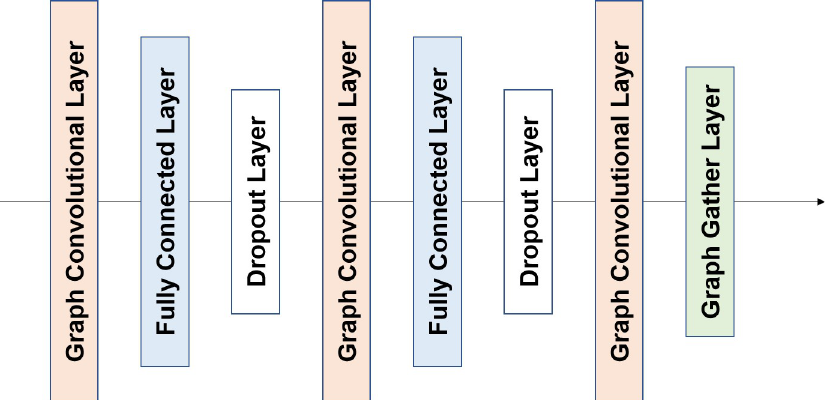
Fig 3. The framework of the graph convolutional block. Each graph convolutional block consists of three graph convolutional layers. The graph convolutional layers are combined with a fully connected layer and a dropout layer, except for the last graph convolutional layer, which is followed by the graph gather